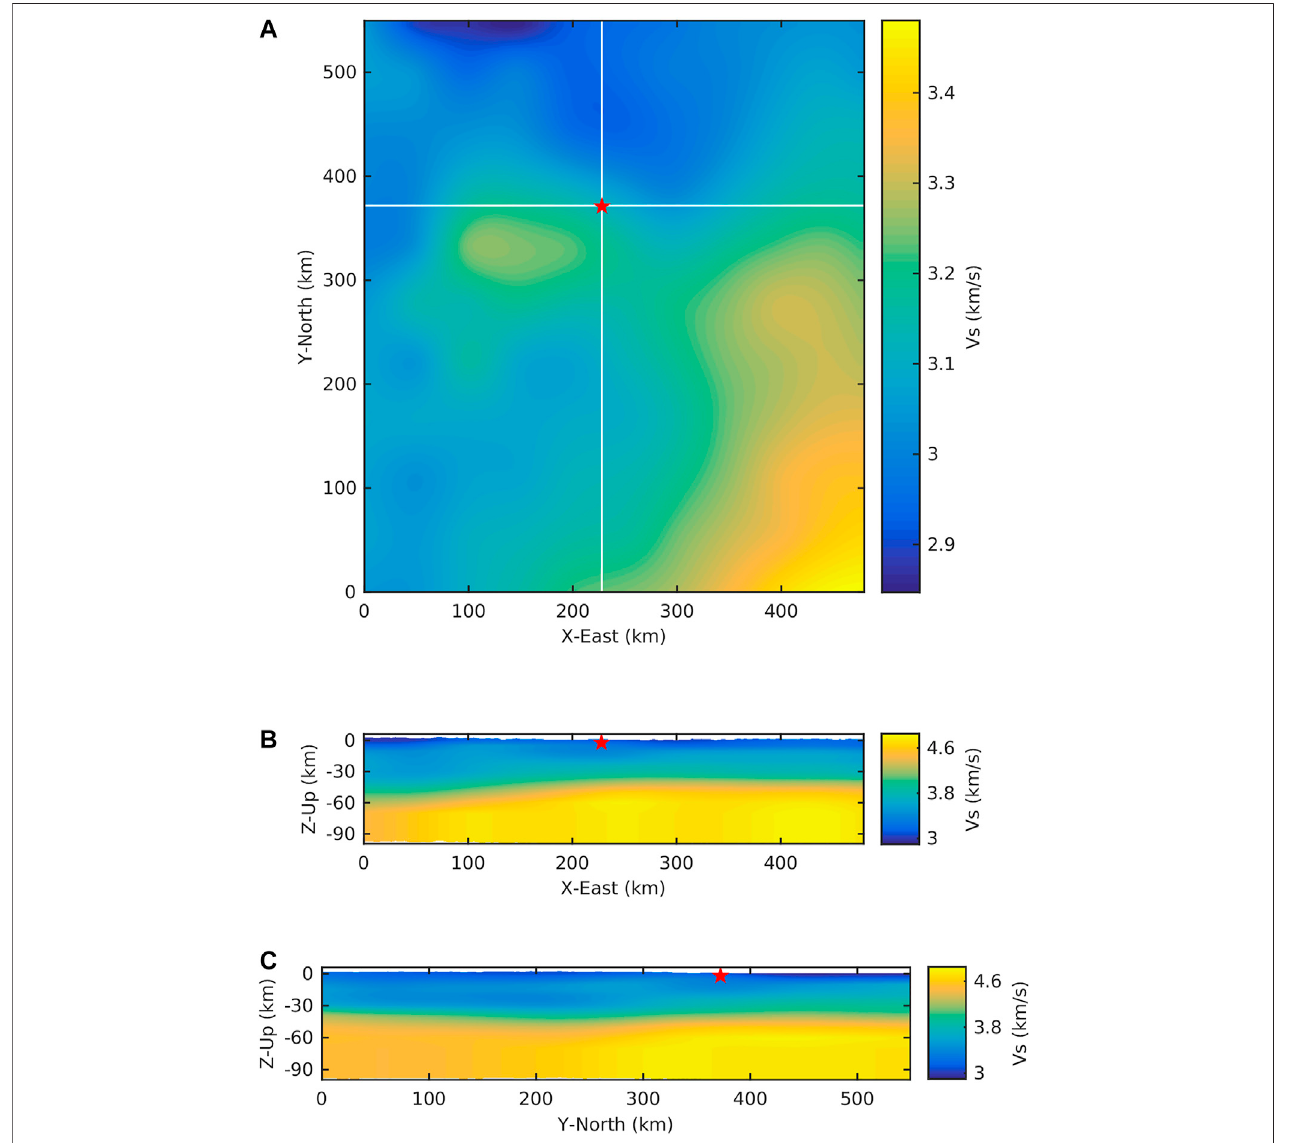
FIGURE 4 | As in Figure 3 , but for S-wave